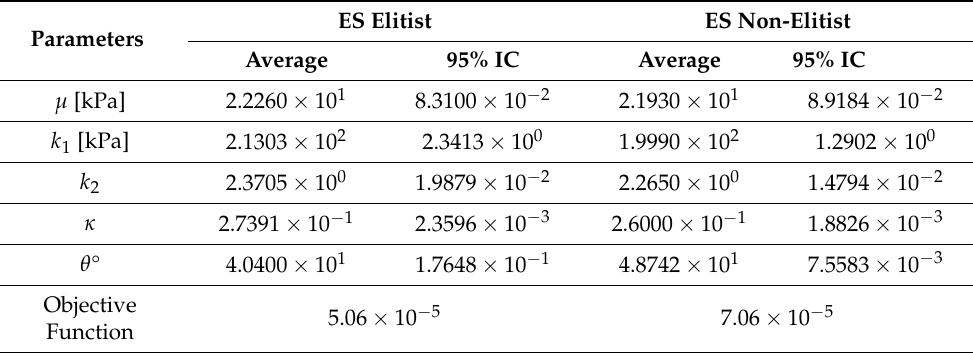
Table 2. Results of the adjustment of a known solution using the GHO model.